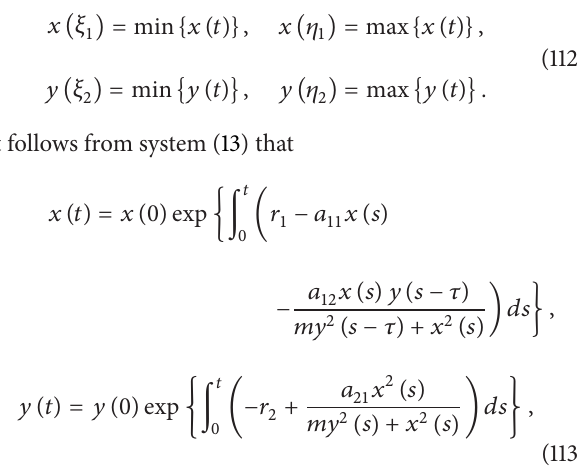
+ 𝑟 /3, 𝐿2 : 2 2 ) , and 𝐿3 : 𝑟 = 2 1